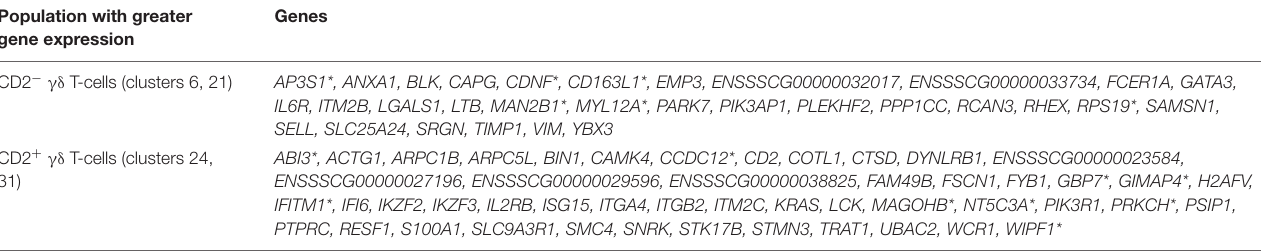
TABLE 5 | Genes differentially expressed between both CD2 − γδ T-cell clusters (clusters 6 and 21) and both CD2 + γδ T-cell clusters (clusters 24 and 31). Population with greater gene expression